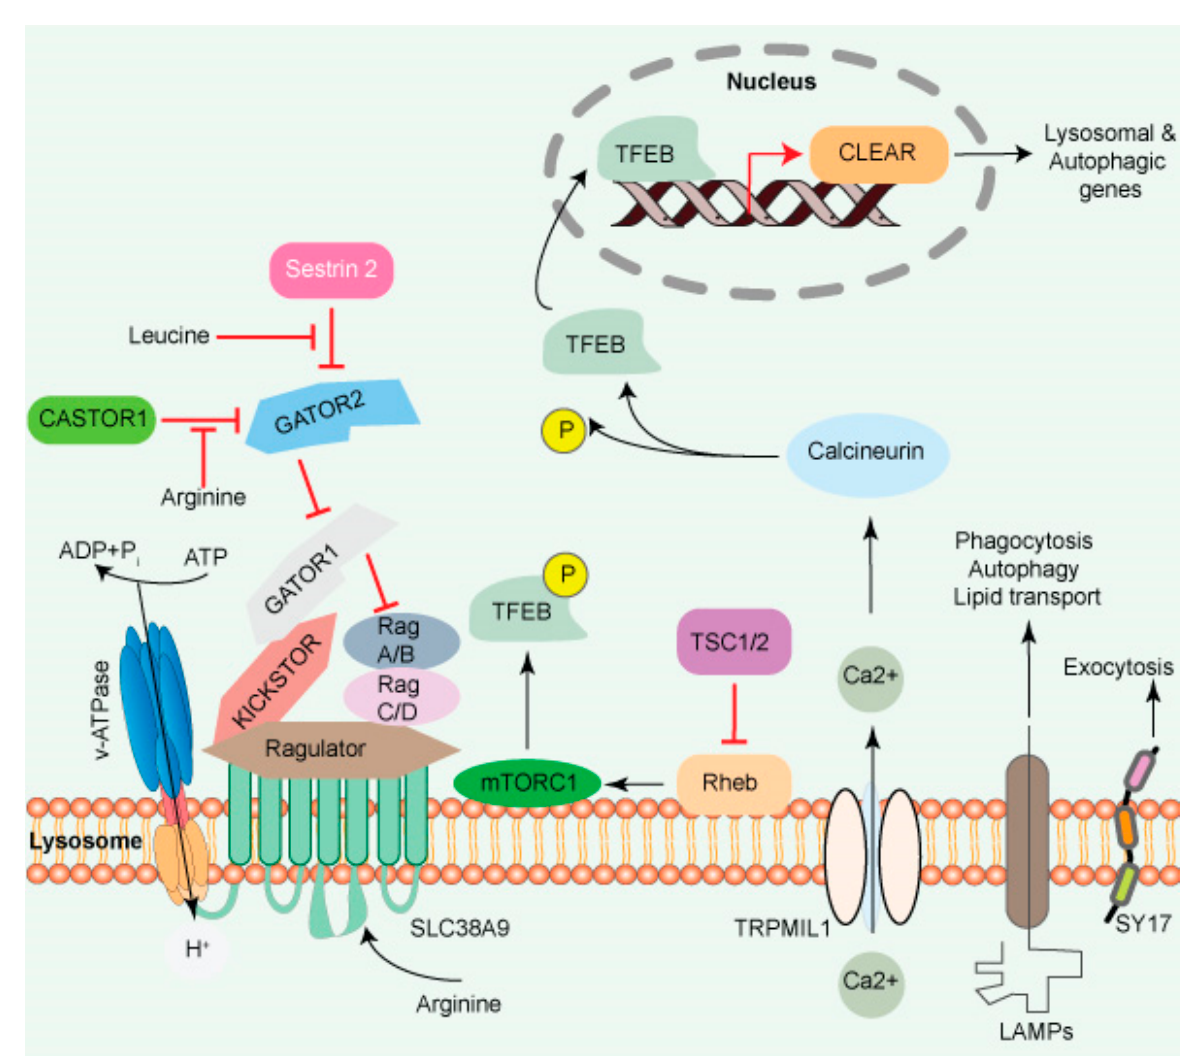
Figure 1. The lysosome surface is a hub of signaling activity. Several proteins found in lysosomal membranes are involved in various signaling cascades. The vacuolar-type H + ATPase (V-ATPase) is a proton pump that regulates pH. mTORC1 connects metabolism and signaling. Intra- and extra- luminal amino acid signaling may affect the mTORC1 signaling pathway’s components. The amino acid transporter SLC38A9 detects arginine in the lysosomal lumen and activates mTORC1 via the Rag GTPases and Ragulator complex. A leucine sensor in the cytosol, Sestrin 2, controls mTORC1 activity with the assistance of GATOR proteins. mTORC1 also affects lysosome biogenesis adversely. Ca 2+ triggers the initiation of lysosome biogenesis. Once Ca 2+ is released into the cytoplasm, it dephosphorylates TFEB, allowing it to translocate to the nucleus, where it aids in the transcription of the CLEAR network genes and activates lysosomal and autophagic transcription. Transmembrane proteins such as LAMPs are involved in autophagy, lipid transport, and immunological response. SYT7 is a calcium-dependent membrane protein involved in lysosomal exocytosis. Additionally, the presence of specific AA residues modulates the activity of addi- tional GEFs and GTPase-activating proteins (GAPs), which are downstream of GTP-RagA A transporter protein, SLC38A9 facilitates the efflux of AA such as leucine from the lysosome lumen [13,28,29]. Increased intraluminal leucine levels also activate Rags (GATOR) complex is a critical integrator of amino acid signaling [25]. GATOR has